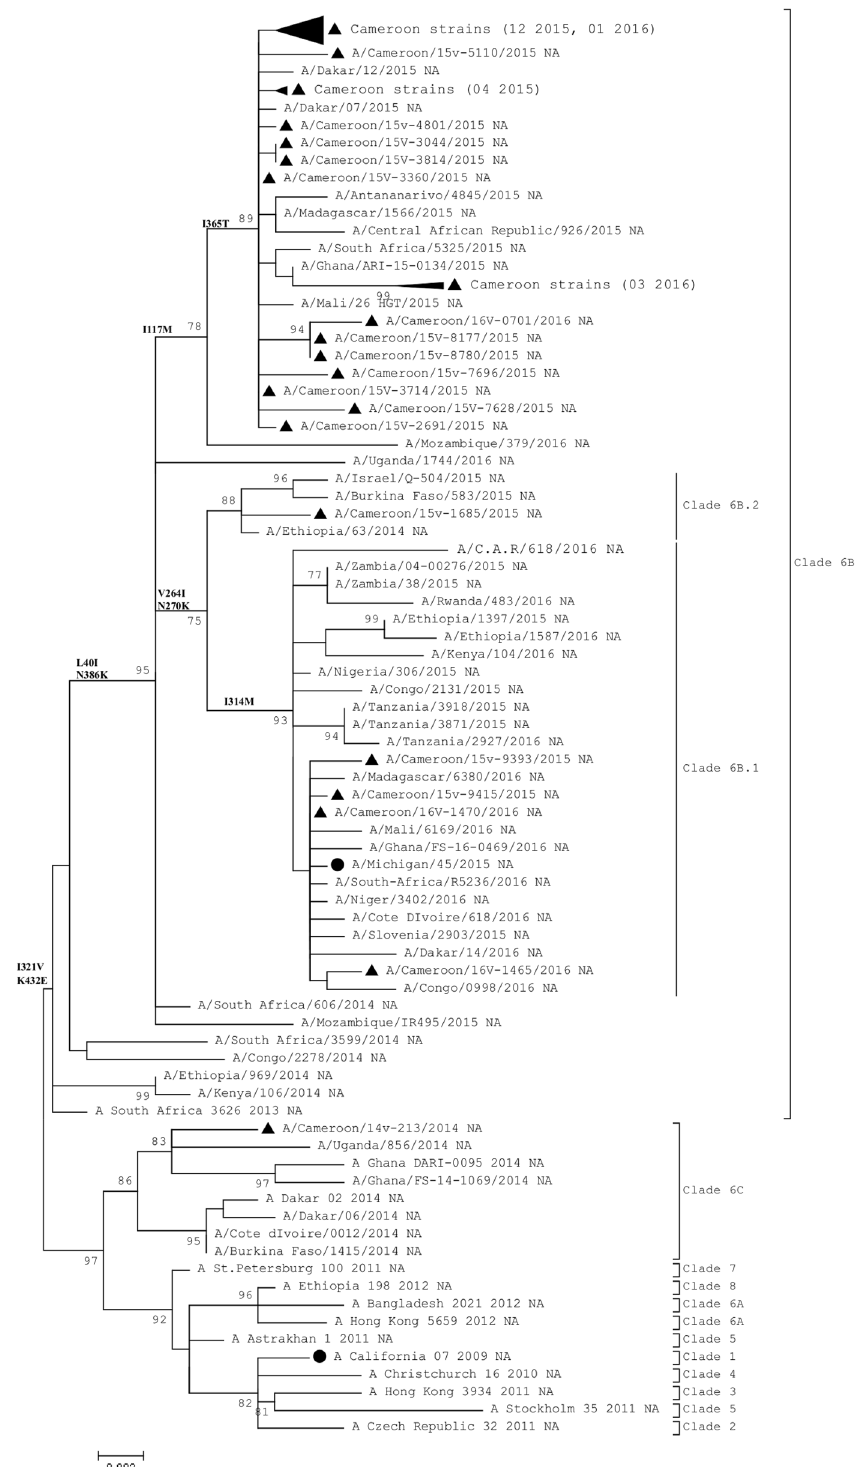
Fig 2. Phylogenetic analysis of NA nucleotide sequences of Influenza A(H1N1)pdm09. ● represents the Northern hemisphere vaccine strains recommended by WHO and ▲ represents Cameroon strains. The evolutionary history was inferred by using the Maximum Likelihood method based on the Kimura 2-parameter model. The percentage of trees in which the associated taxa clustered together is shown next to the branches.